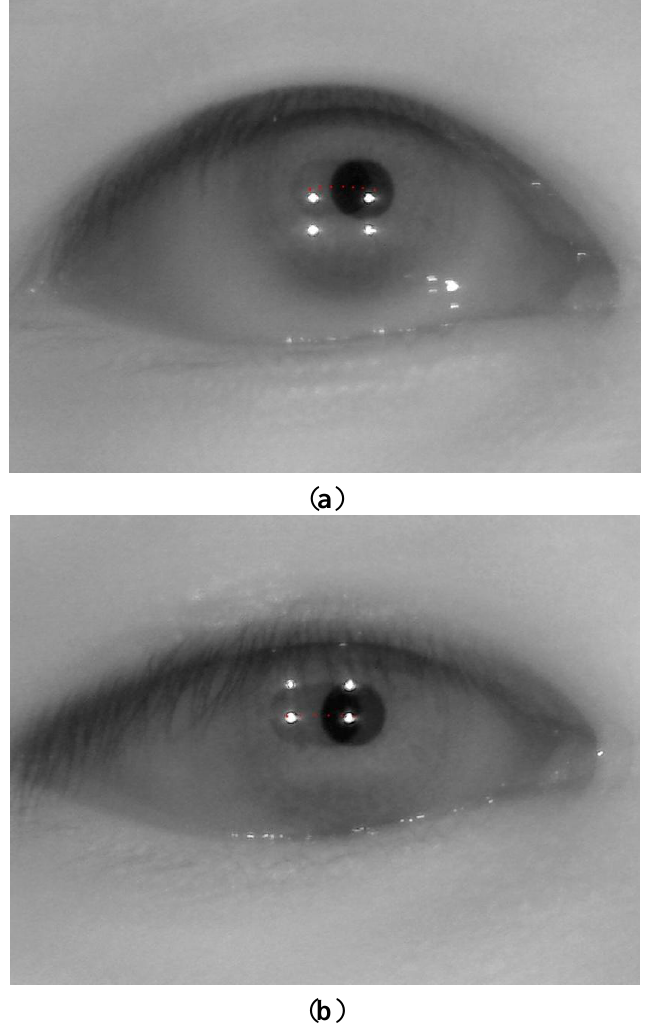
Figure 14. Locus of pupil centers. ( a ) In case of gazing at the left upper-most to right upper-most position. ( b ) In case of gazing at the left lower-most to right lower-most